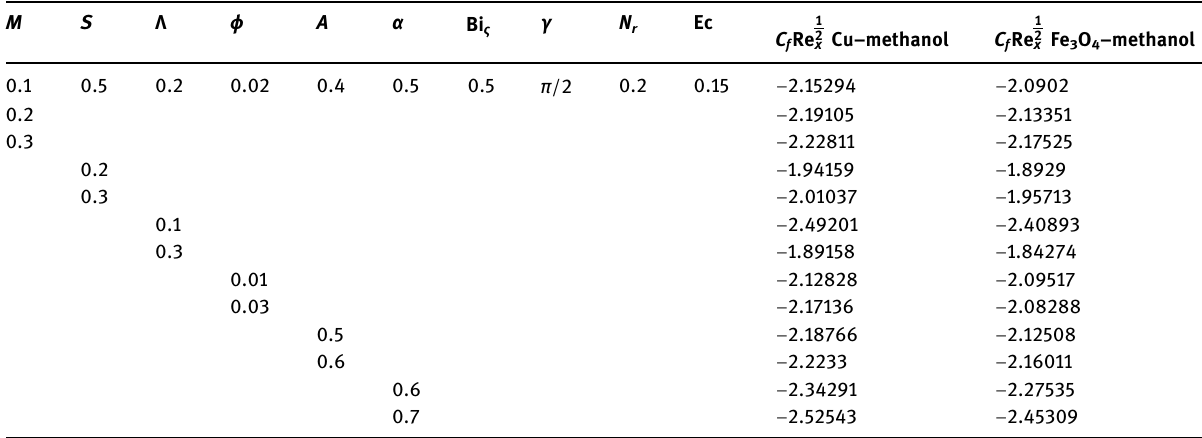
Table 5: In fl uence of varied dimensional parameters on skin